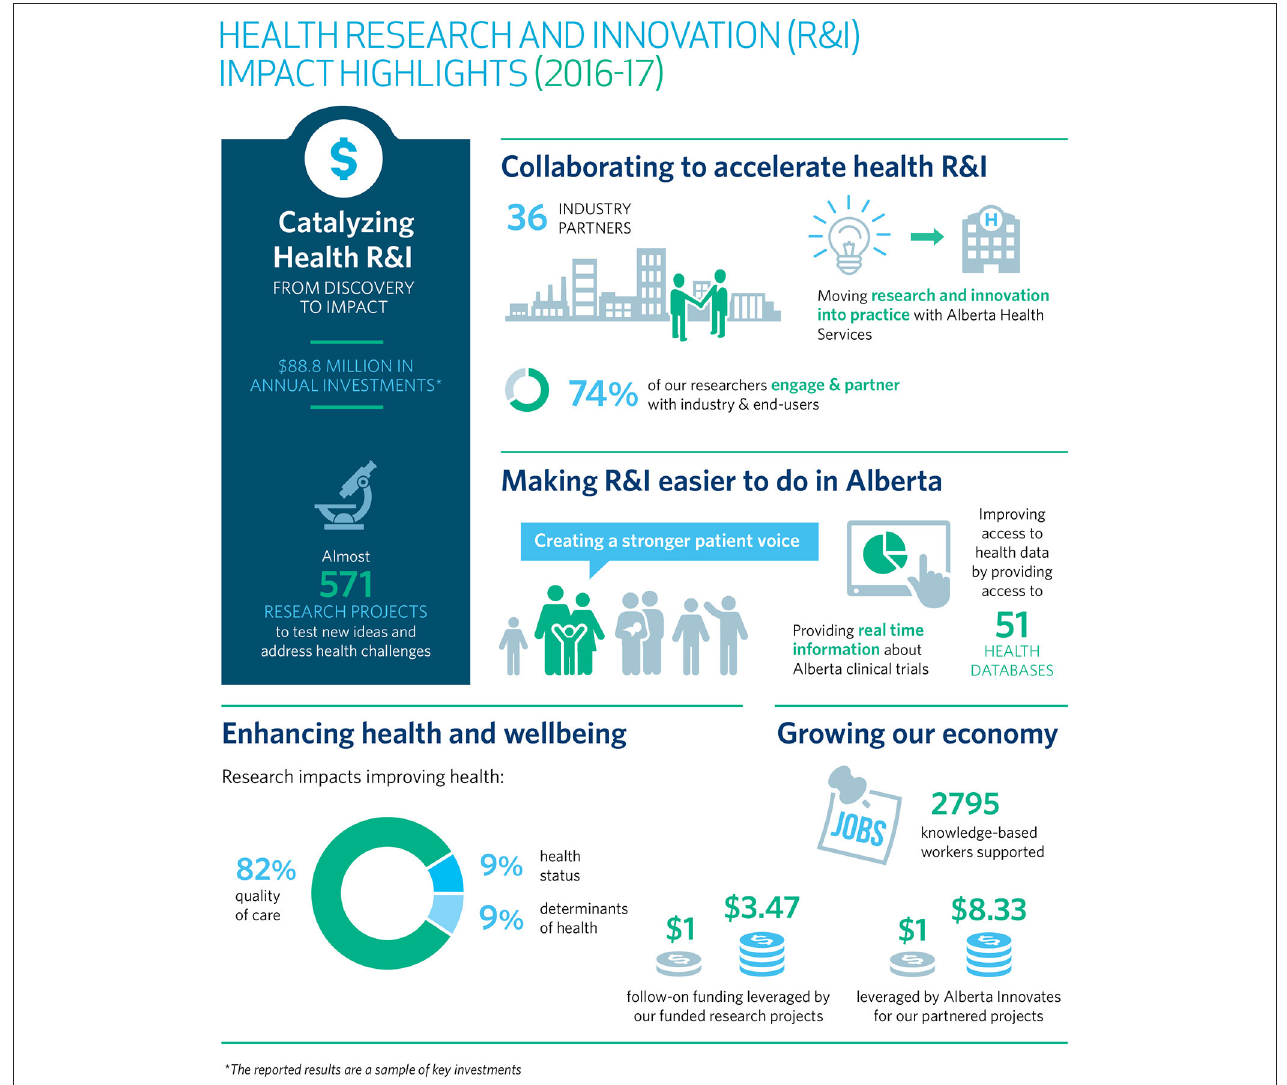
FIGURE 4 | Scorecard from the Alberta Innovates Annual Impact Report for Health Innovation: